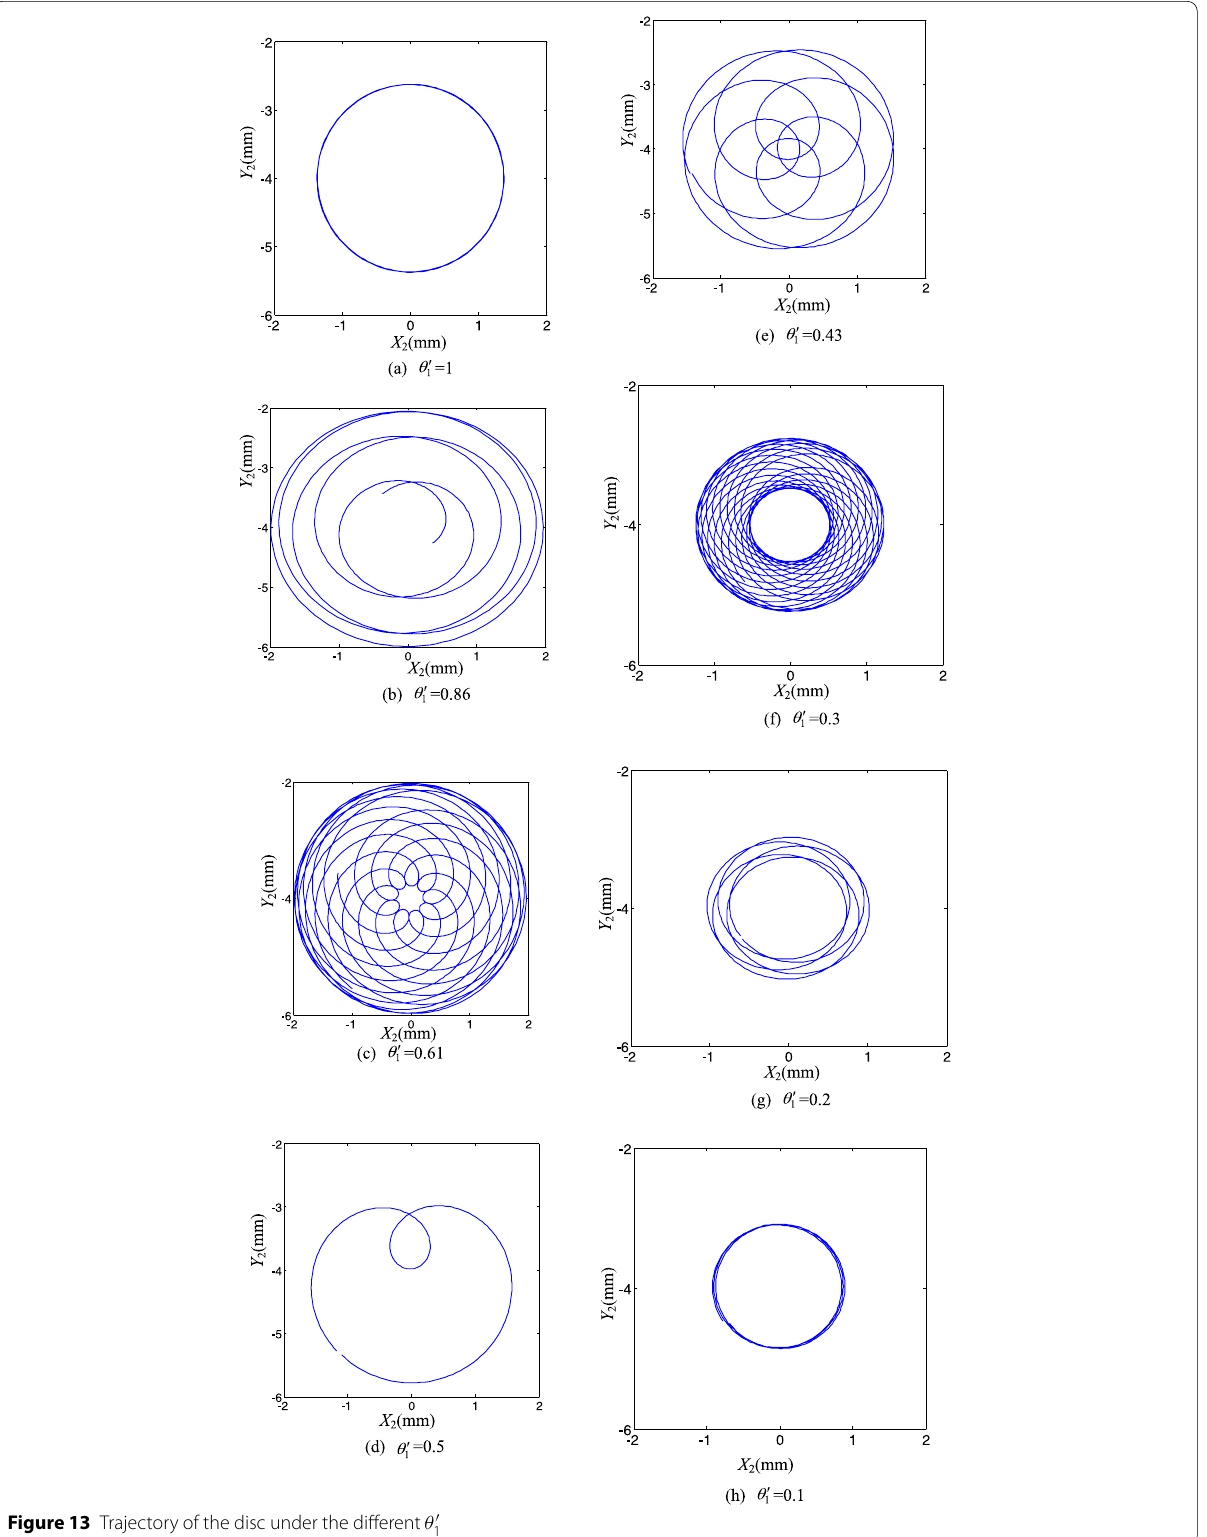
Figure 13 Trajectory of the disc under the different θ ′